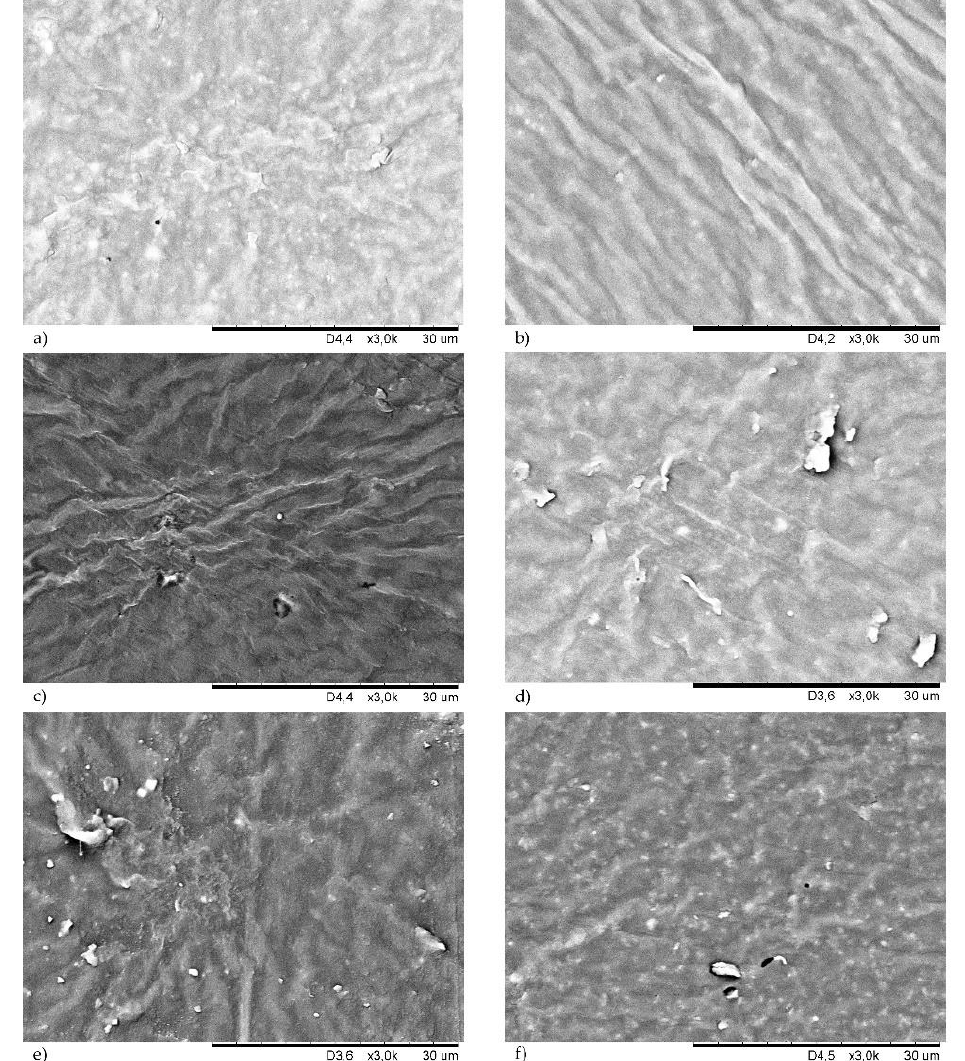
Figure 9. SEM images of the vulcanizates surface of: unfilled CR/CuO ( a ); CR/CuO/Si ( b ); CR/CuO/Ch ( c ); CR/CuO/Ka ( d ); CR/CuO/MMT ( e ); CR/CuO/CB ( f ).